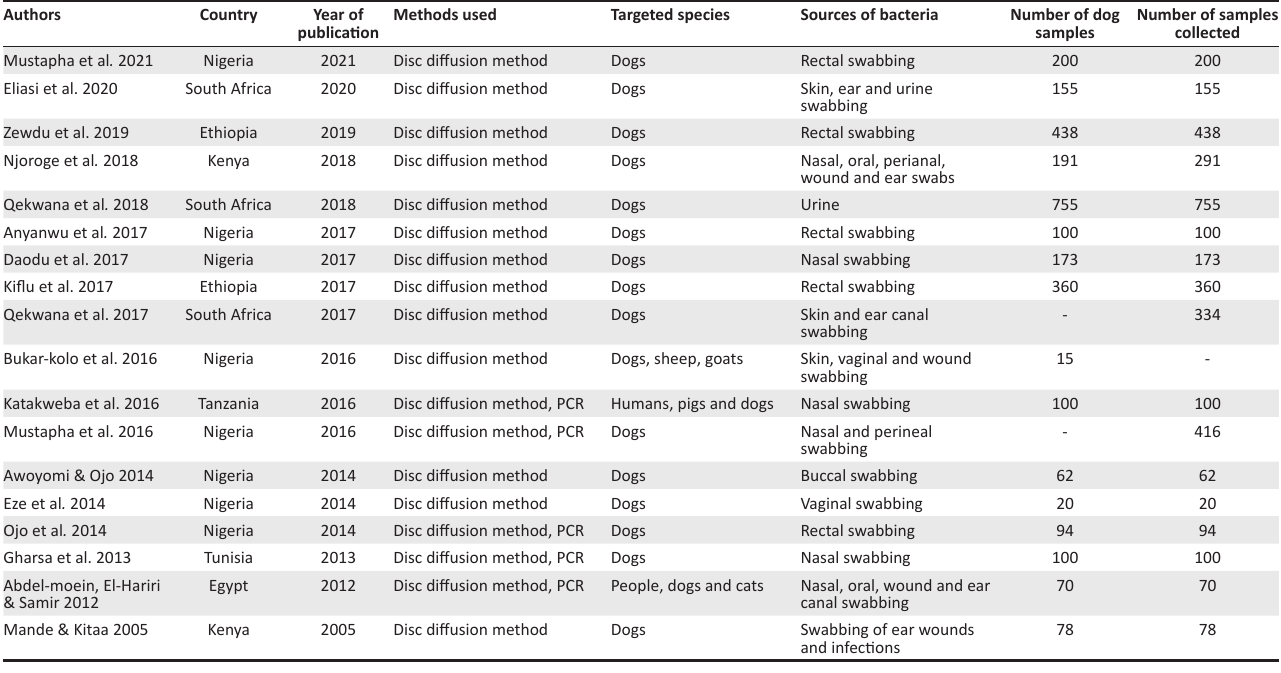
TABLE 1: The outline of selected antimicrobial resistance studies in dogs.